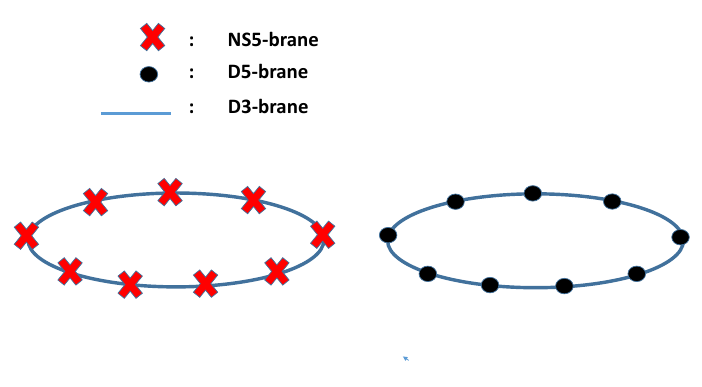
Figure 3: Brane construction of the quiver gauge theory and its mirror